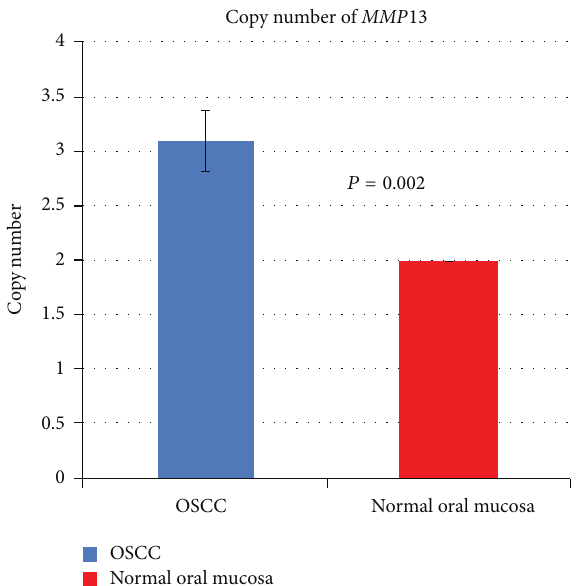
Figure 2: Copy number alterations of MMP13 between OSCC and normal oral mucosa. The copy number alterations of MMP13 between OSCC and normal oral mucosa tissues were statistically different ( 𝑃 = 0.002 ) with an average of 3.09 copies. The copy number for normal oral mucosa (NT) of MMP13 was 2 due to presentation as two diploid copies as reference control.